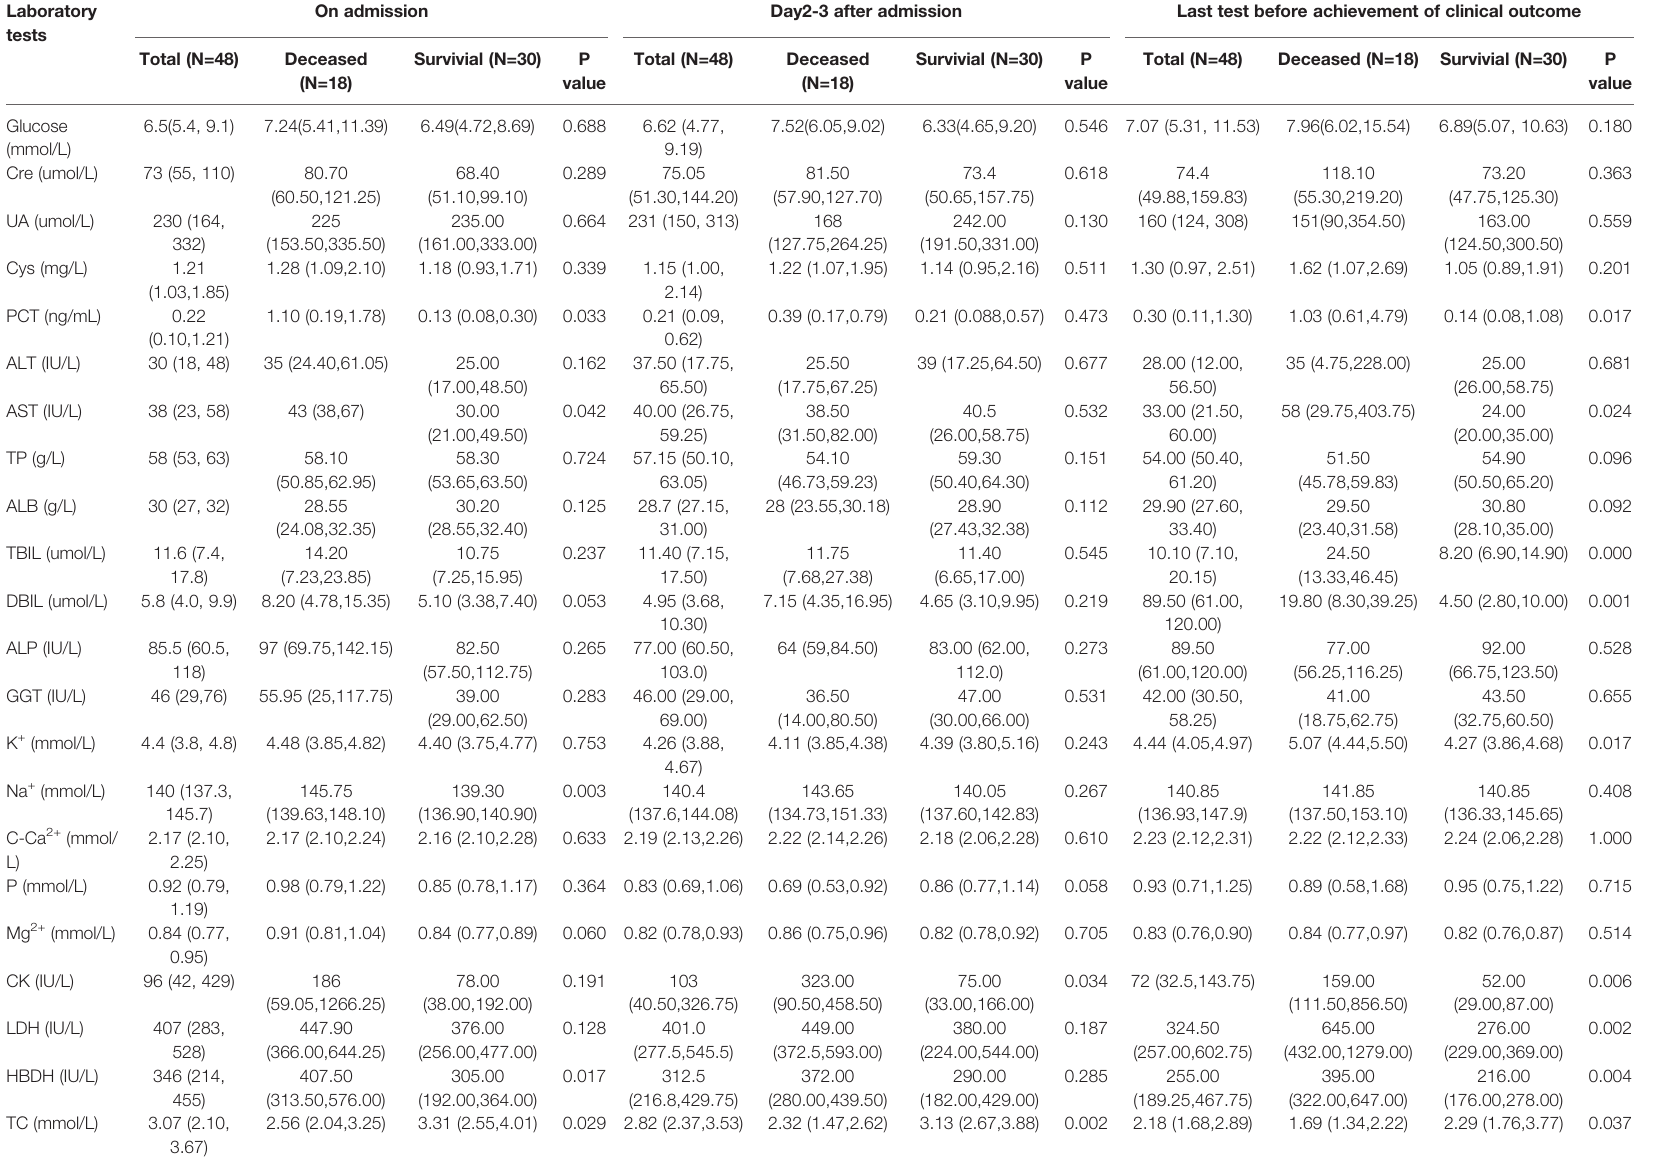
TABLE 3 | Main clinical laboratory pro fi les of critical patients with